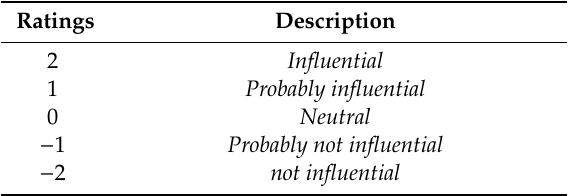
Table 2. Users’ rating of an indoor position.